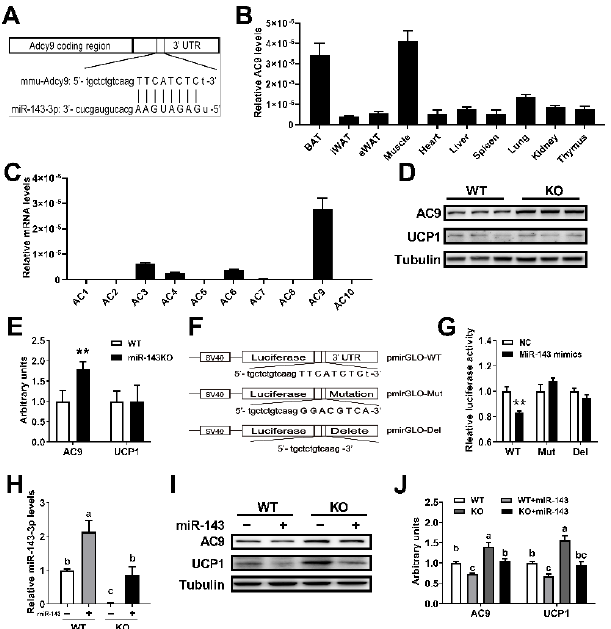
Figure 6. miR-143 targets AC9. ( A ) The predicted target site for miR-143 in the 3 (cid:48) -UTR of AC9. ( B ) The tissue distribution of mRNA encoding AC9 (n = 6–8). ( C ) The type 1 to 10 adenylyl cyclase mRNA expression levels in BAT (n = 6–8). ( D , E ) The AC9 and UCP1 protein expression levels in the BAT of WT and KO mice fed ND (n = 3). ( F ) AC9 3 (cid:48) -UTR with fully changed nucleotides in the seed sequence or with a deleted seed sequence disrupts the binding of miR-143. ( G ) Three 3 (cid:48) -UTR sequences were respectively cloned into the pGL3-Control vector downstream of the luc + gene, and luciferase assays with the constructed vectors were transfected into differentiated 3T3-L1 cells with negative control (NC) or miR-143 mimic were performed (n = 8–10). ( H – J ) The miR-143 ( H ) (n = 4) and AC9 protein ( I , J ) (n = 3) expression levels in WT or KO brown adipocytes treated with blank or miR-143 expression lentivirus. Data are presented as the mean ± SEM. ** p < 0.01 vs. controls. Different letters above groups represent significant differences, with shared letters representing no significant differences, as determined by a two-tailed unpaired Student’s t -test ( E , G ) and two-way ANOVA followed by Tukey’s post hoc test ( H , J